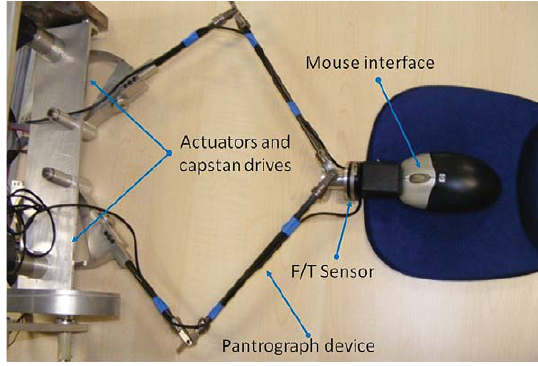
Fig. 1. Picture of the planar pantograph haptic system and its inte- gration with a mouse device.